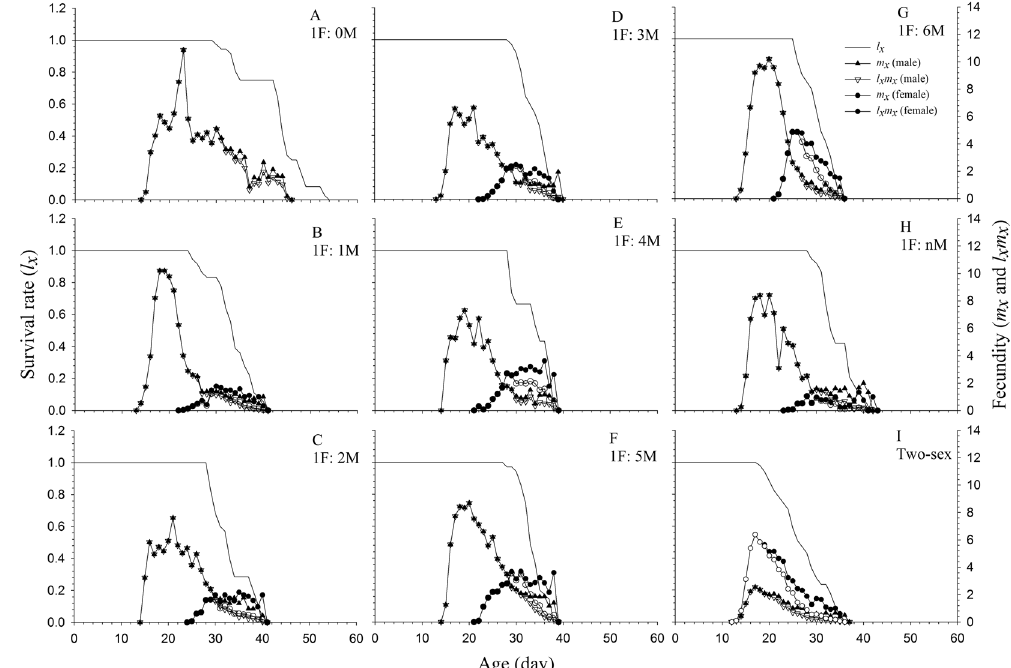
Figure 2. Age-specific survival rate ( l x ), fecundity ( m x ) and maternity ( l x m x ) o of Frankliniella occidentalis at different arrhenotokous sex ratios and bisexual population. A = 1 F:0 M, B = 1 F:1 M, C = 1 F:2 M, D = 1 F:3 M, E = 1 F:4 M, F = 1 F:5 M, G = 1 F:6 M, H = 1 F:nM, I =